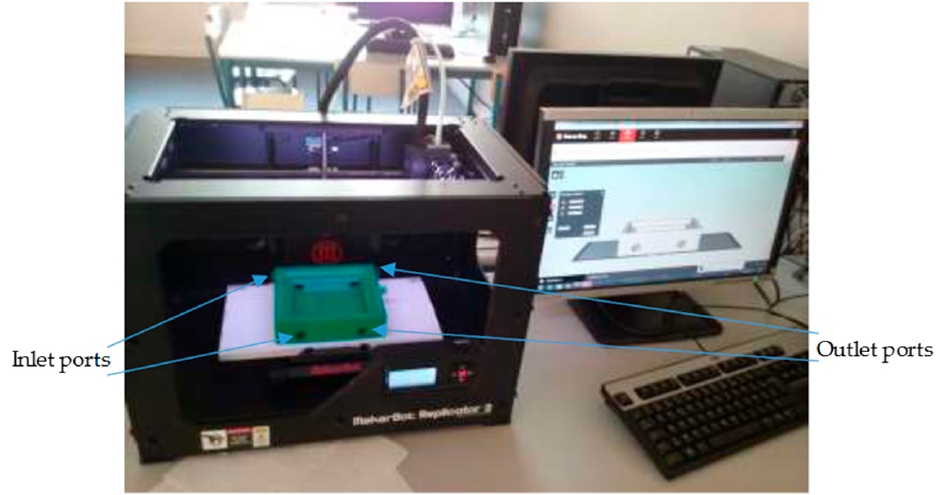
Figure 2. Image of 3D printer and fabricated cold compartment.